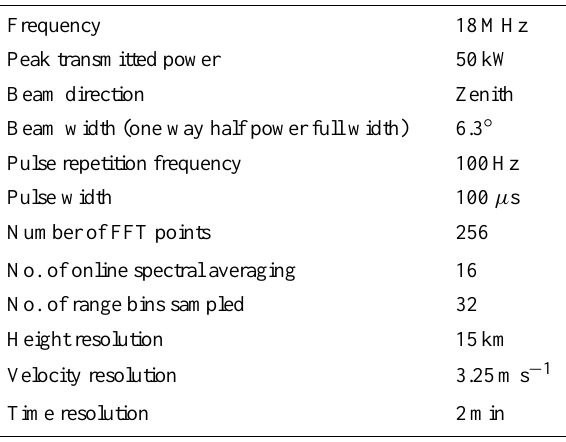
Table 1. Radar parameters and other specifications used for the spread F